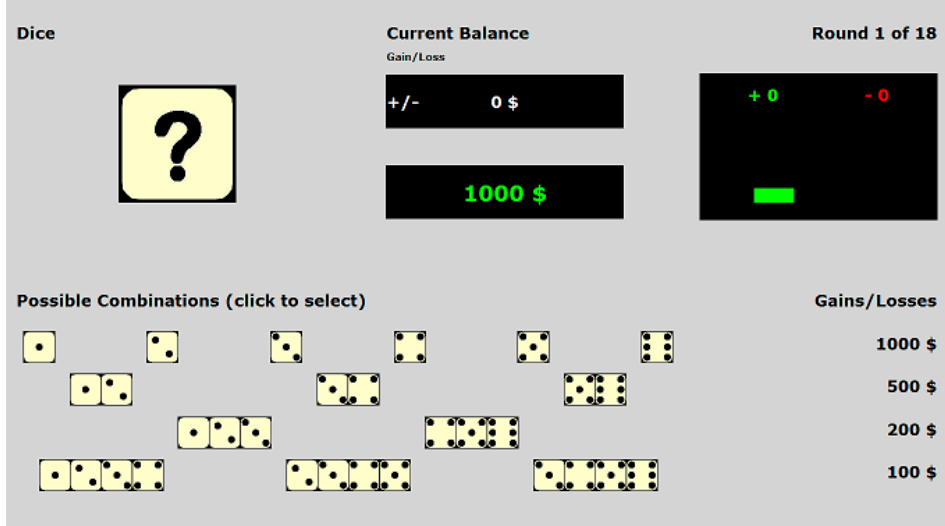
Figure 1. Screenshot of Game of Dice Task (GDT).